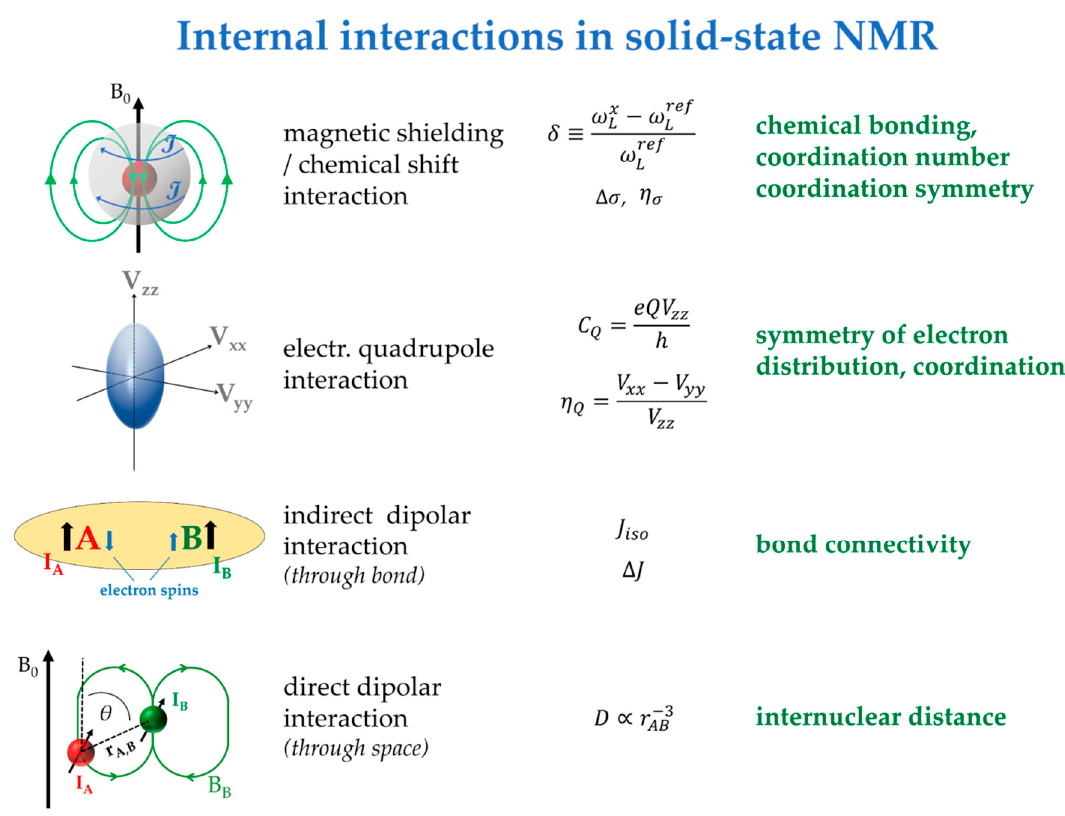
Figure2. Anisotropicinteractionsinfluencingtheappearanceofsolid-stateNMRspectrafordiamagnetic solids, parameters extractable from the NMR spectra describing these interactions, and the structural information they are connected